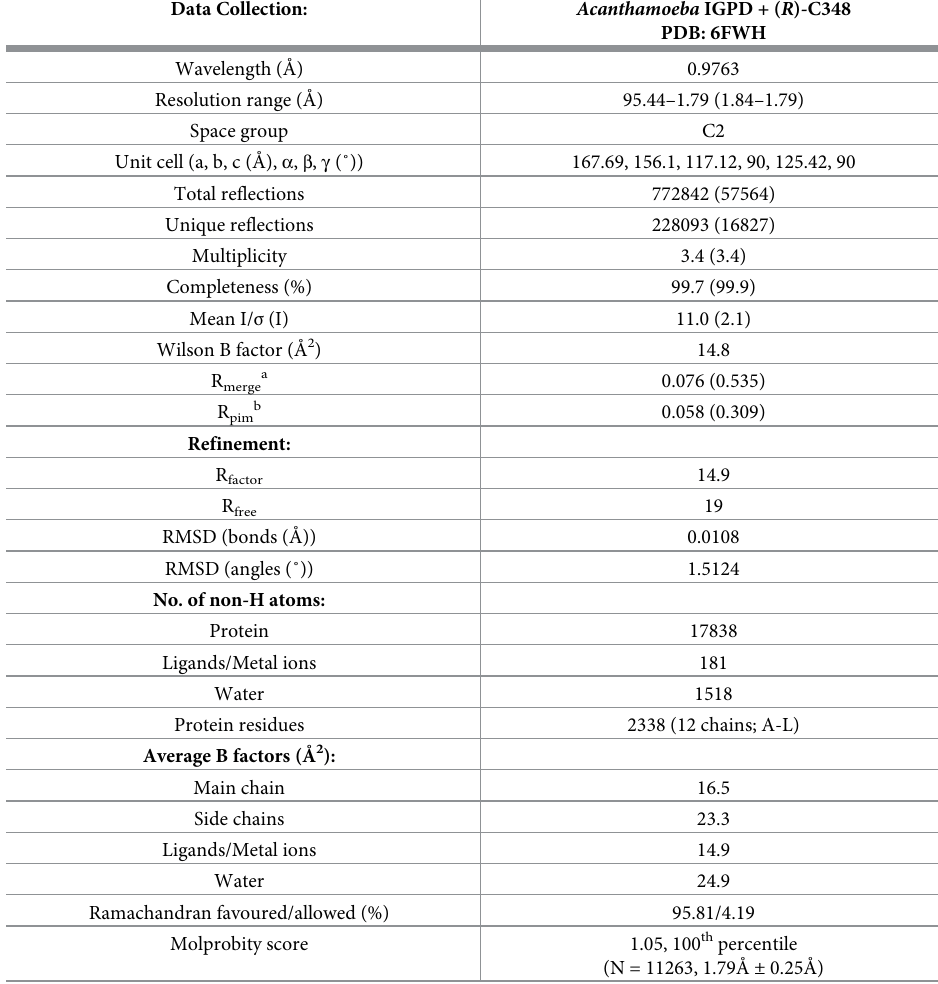
Table 3. Crystallographic data collection and refinement